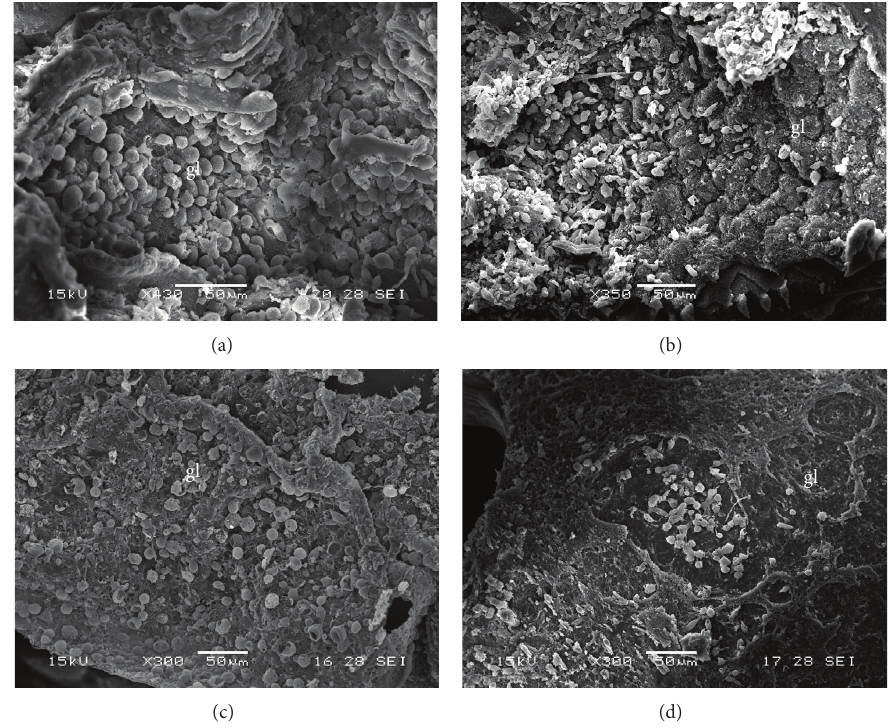
Figure 9: Scanning electron microscopy of E. granulosus murine cysts incubated in vitro with thymol and essential oils of T. vulgaris and O. vulgare . (a) Control murine cyst with an intact germinal layer (6 days p.i., gl: germinal layer; 430x). (b) Cyst incubated with T. vulgaris during 6 days (350x). The germinal layer is altered. (c) Cyst exposed to O. vulgare after 6 days p.i. (500x). (d) Extensive damage of the germinal layer (thymol, 3 days p.i., 300x). Only cellular debris could be